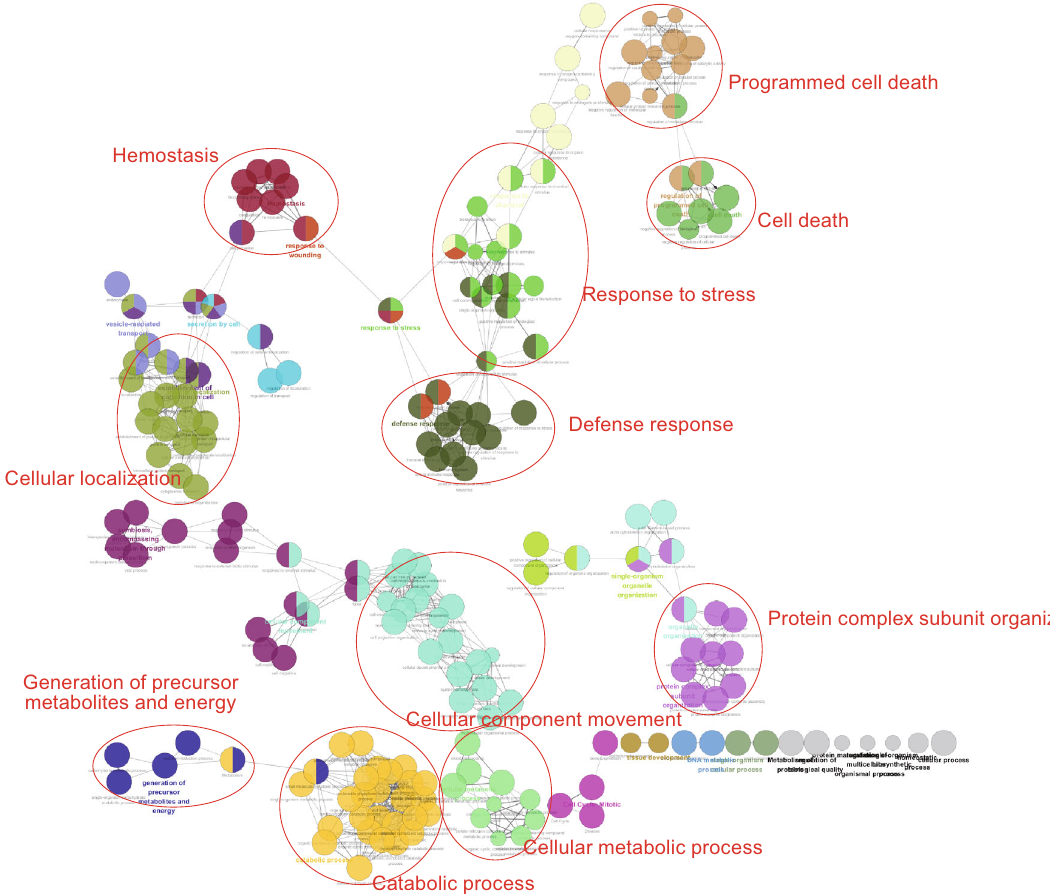
Figure 3. Network reconstruction of functional terms. Each dot represents one functional term. The same color dots represent terms which have similar biological functions. Accordingly, all terms were classi fi ed into different functional modules including “ defense response, ” “ response to stress, ” “ hemostasis ” and “ cellular localization